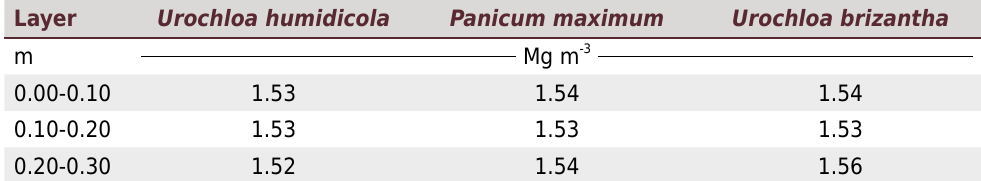
Table 6. Estimated critical values of soil bulk density for root growth (BDc Rest) for the 0.00-0.10, 0.10-0.20, and 0.20-0.30 m layers of the constructed mine soil revegetated by grasses using